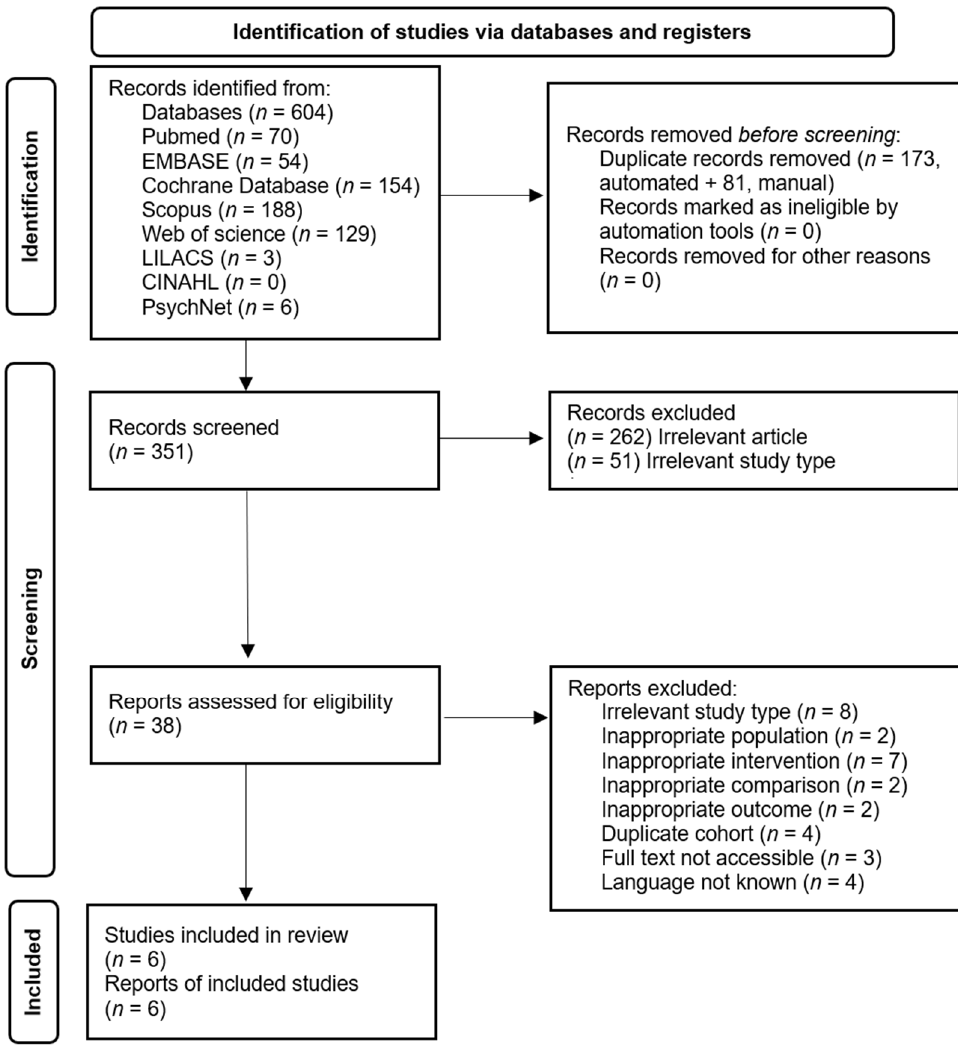
Figure 1. PRISMA flowchart.